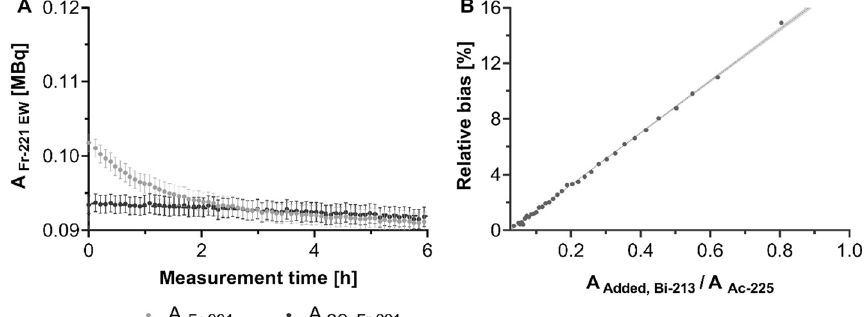
Fig. 6 A 225 Ac activities measured with EW 221 with and without scatter correction are plotted as function Fr of measurement time for the sample 3 (see Table 1) containing 225 Ac and additional 213 Bi activity. Error bars represent the standard deviation provided by the GC software. B Relative bias (percentage relative difference) of 225 Ac activity estimated using EW 221 as function of the added 213 Bi activity (compared to SEq between Fr 225 Ac and 213 Bi) when no correction for the additional down scatter of 213 Bi gamma‑emissions in the EW 221